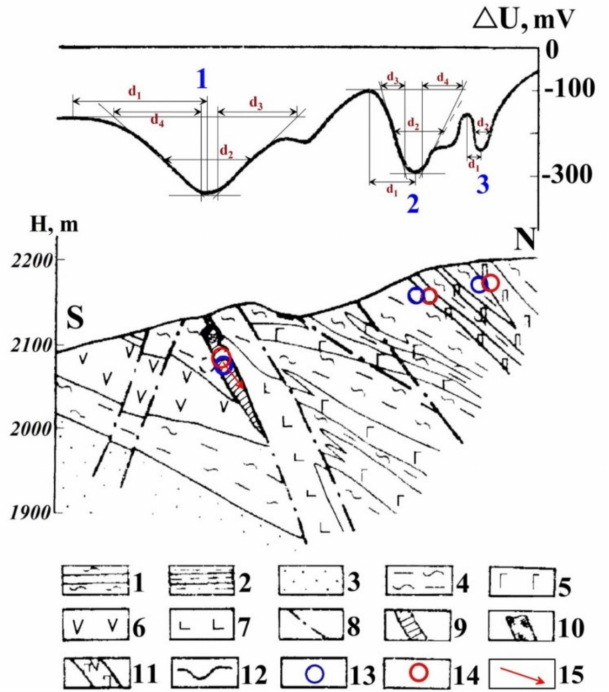
Figure 7. Results of the quantitative interpretation of SP anomalies in the area of the Katsdagh copper- polymetallic deposits on the southern slope of the Greater Caucasus (Azerbaijan). (1) Interbedding of sands and clay schists, (2) clay schists with the flysh packages, (3) clay sandstone; (4) sand-clay schists; (5) diabases, gabbro-diabases and diabasic porphyrites; (6) andesites and andesite-porphyrites; (7) dacitic porphyrites; (8) faults; (9) massive ore of pyrite-polymetallic composition; (10) oxidized ore; (11) zones of brecciation, crush and boudinage with lean pyrite-polymetallic ore; (12) SP curves; location of anomalous source: (13) without calculation of the inclined relief influence, (14) after introducing correction for the terrain relief, (15) direction of the self-potential